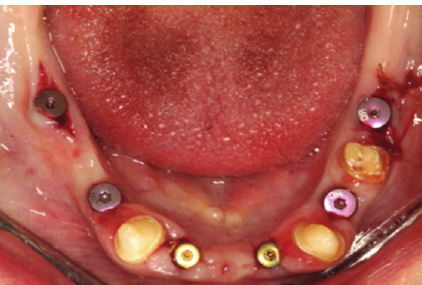
Figure 8: Soft tissue enhancement around lower molar implants, during stage 2 implant uncovery.